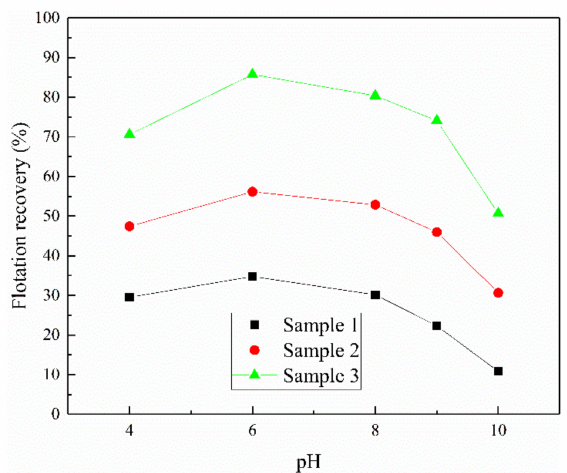
Figure 4. Flotation recovery of three samples as a function of the pH (xanthate = 6 × 10 − 5 mol /